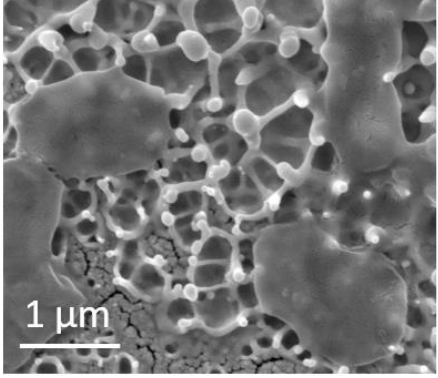
Figure 9. SEM image of damaged S. aureus cells on the surface of Au nanospikes.